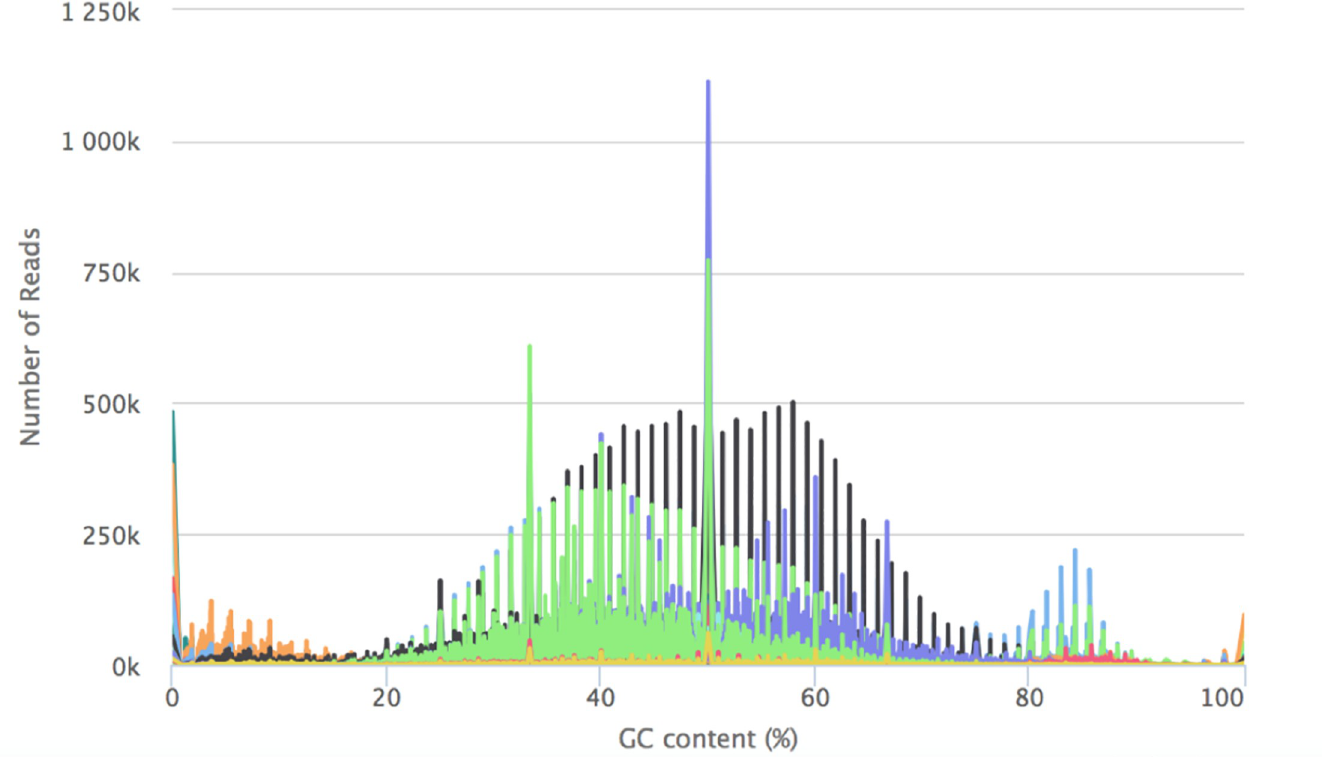
Fig 5. All sample GC content versus number of reads. The plot shows the GC distribution scaled to 100 bins. The vertical bars with the same color denote the GC distributions for the same sample.